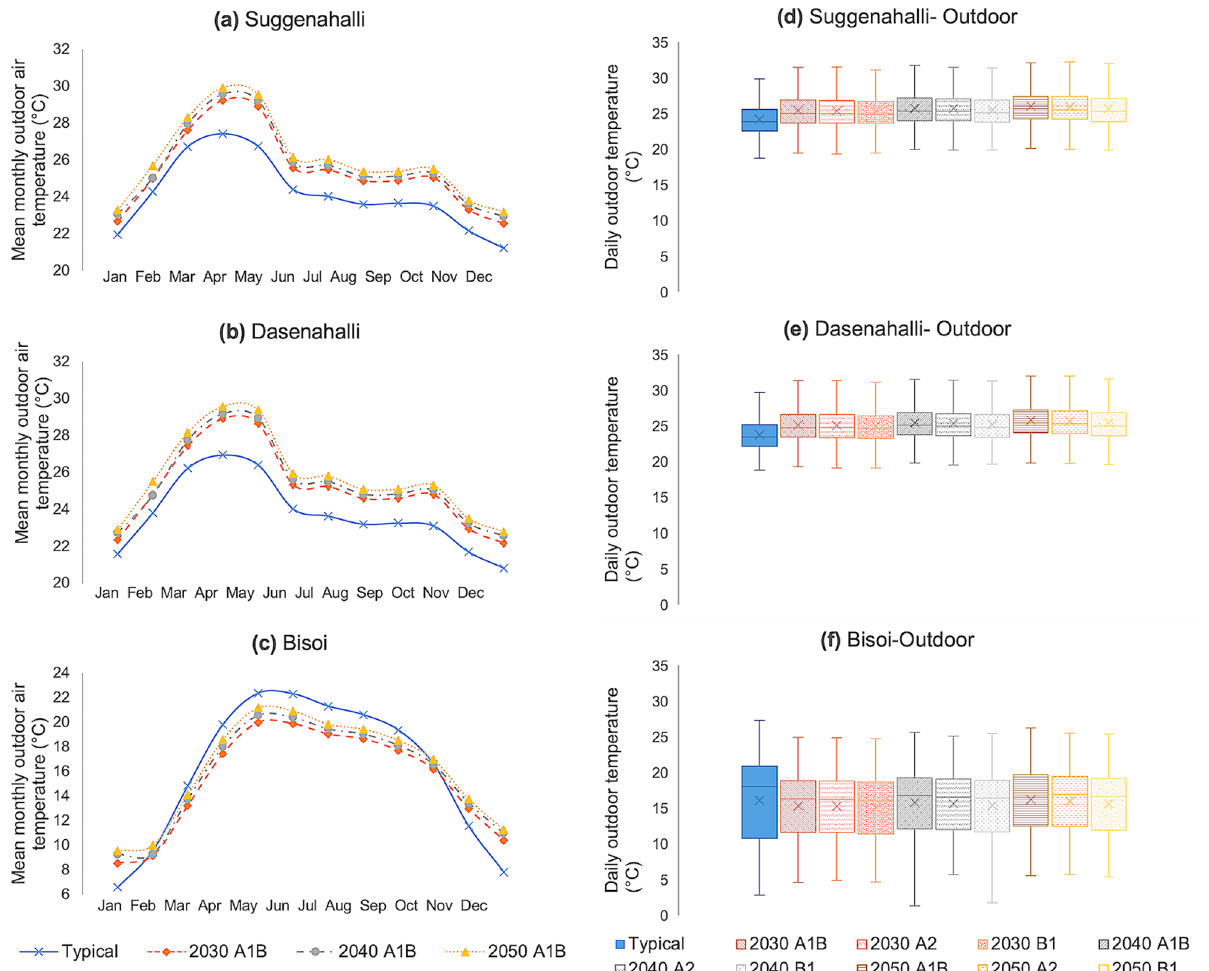
Figure 6. ( a )–( c ) Mean monthly outdoor air temperatures for typical and A1B scenario for 2030, 2040 and 2050 and ( d ), ( e ) the range of daily outdoor air temperatures for the three settlements for typical scenario and all future scenarios: ( a ), ( b ) and ( c ) shows the mean monthly outdoor air temperature (in °C) for typical scenario and A1B scenario for the years 2030, 2040 and 2050 for the rural settlements Suggenahalli, Dasenahalli and Bisoi, respectively. The same is not shown for A2 and B1 scenarios but they show similar trend with increasing temperatures with each passing decade. ( d ), ( e ) and ( f ) show the range of outdoor air temperatures (in °C) for typical and all three scenarios for future years 2030, 2040 and 2050 for the rural settlements Suggenahalli, Dasenahalli and Bisoi, respectively. The temperatures tend to increase with each decade with the highest increase in A1B scenario and lowest in B1 scenario for both Suggenahalli and Dasenahalli. In case of Bisoi winters tend to get warmer than typical conditions while summers tend to get cooler than typical conditions. The decadal increase in temperature can be witnessed here as